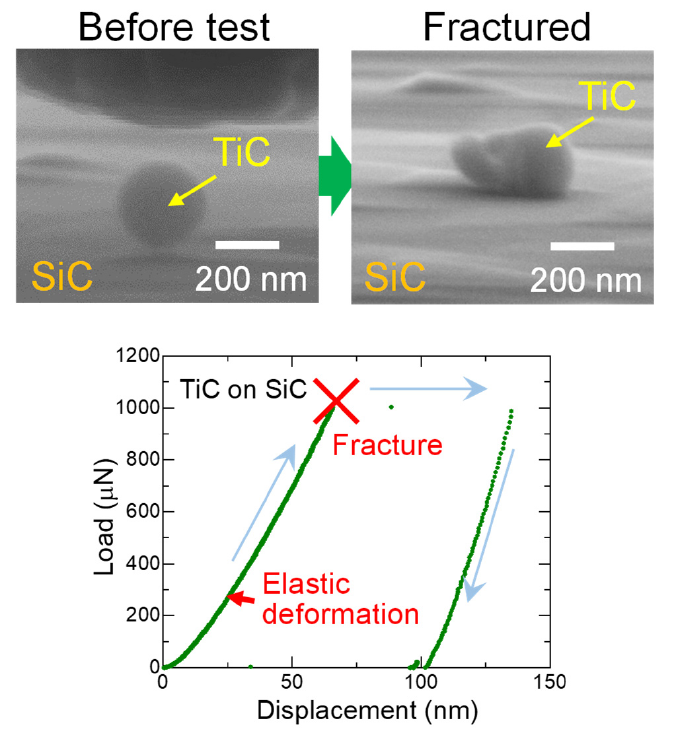
Figure 4. Typical fracture process of a TiC SMP and corresponding load–displacement curve during the compression test.